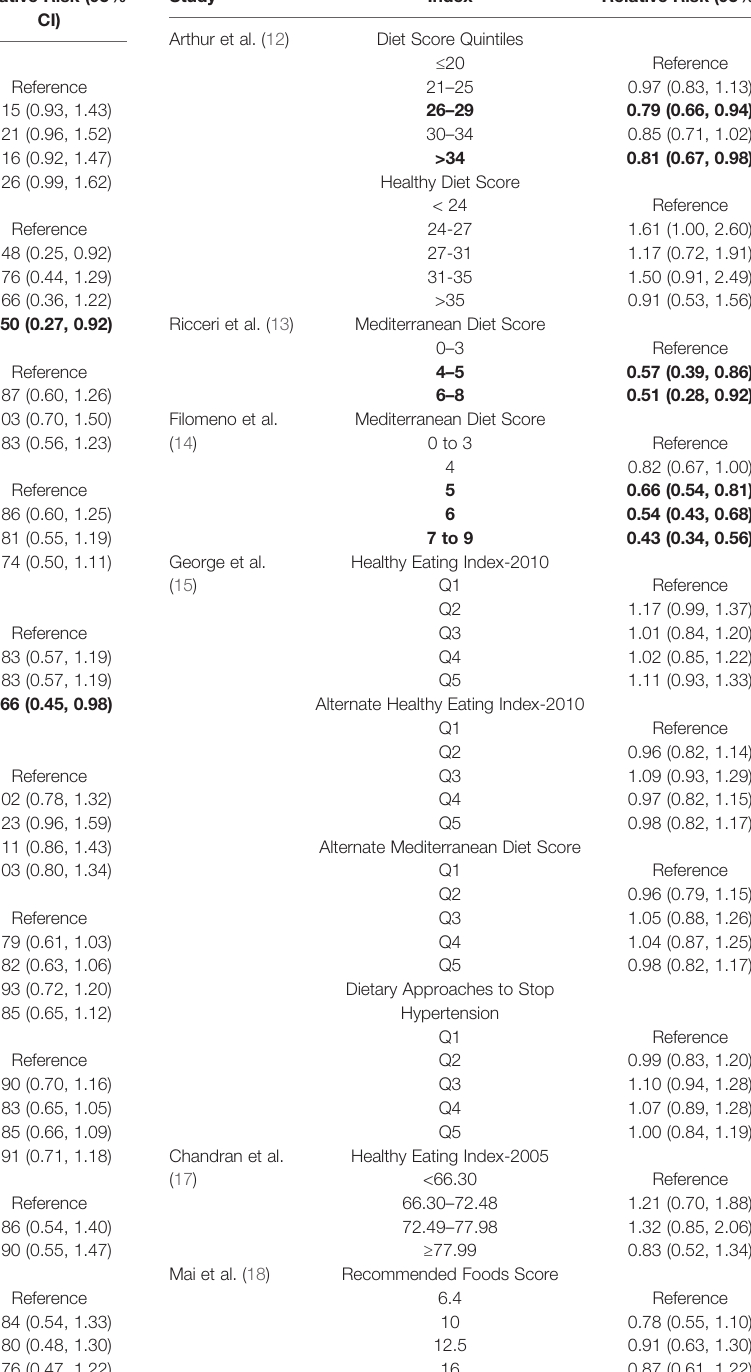
TABLE 2 | Main results for ovarian cancer in the original studies* TABLE 3 | Main results for endometrial cancer in the original